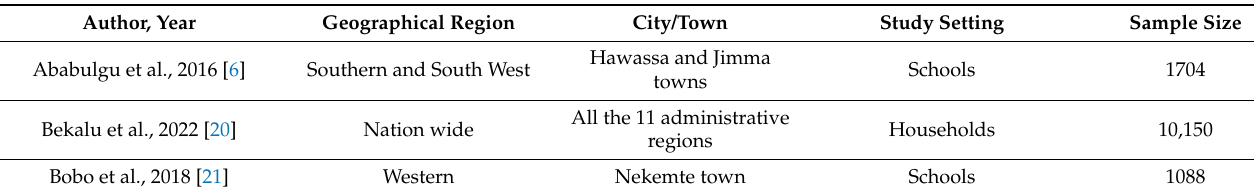
Table 2. General study